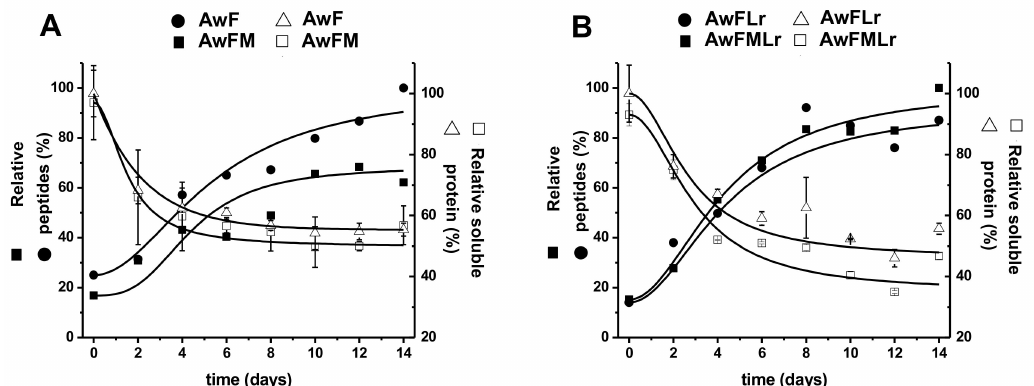
Figure 2. Soluble protein and peptide dynamics: ( A ) AwF and AwFM; ( B ) AwFLr and AwFMLr. Open squares represent relative soluble protein content; open triangles represent relative soluble protein content; filled squares represent relative peptide concentration; filled circles represent relative protein concentration. Error bars represent the standard deviation of three independent experiments.